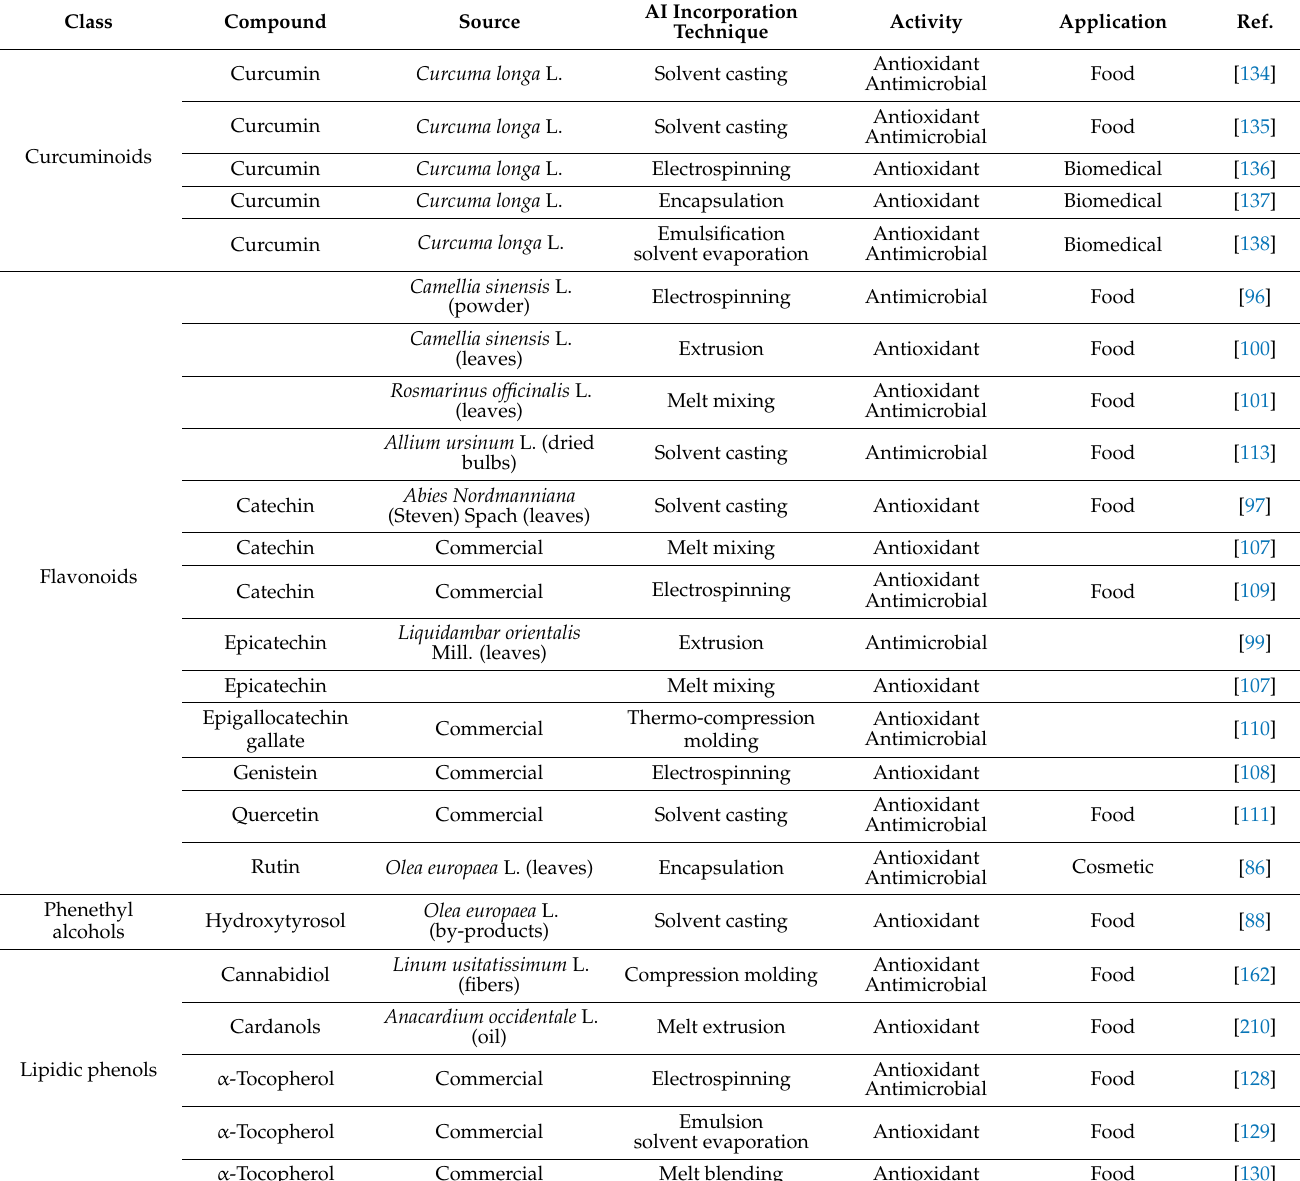
Table 1. Phenolic compounds and polymers used as AIs for PLA-based